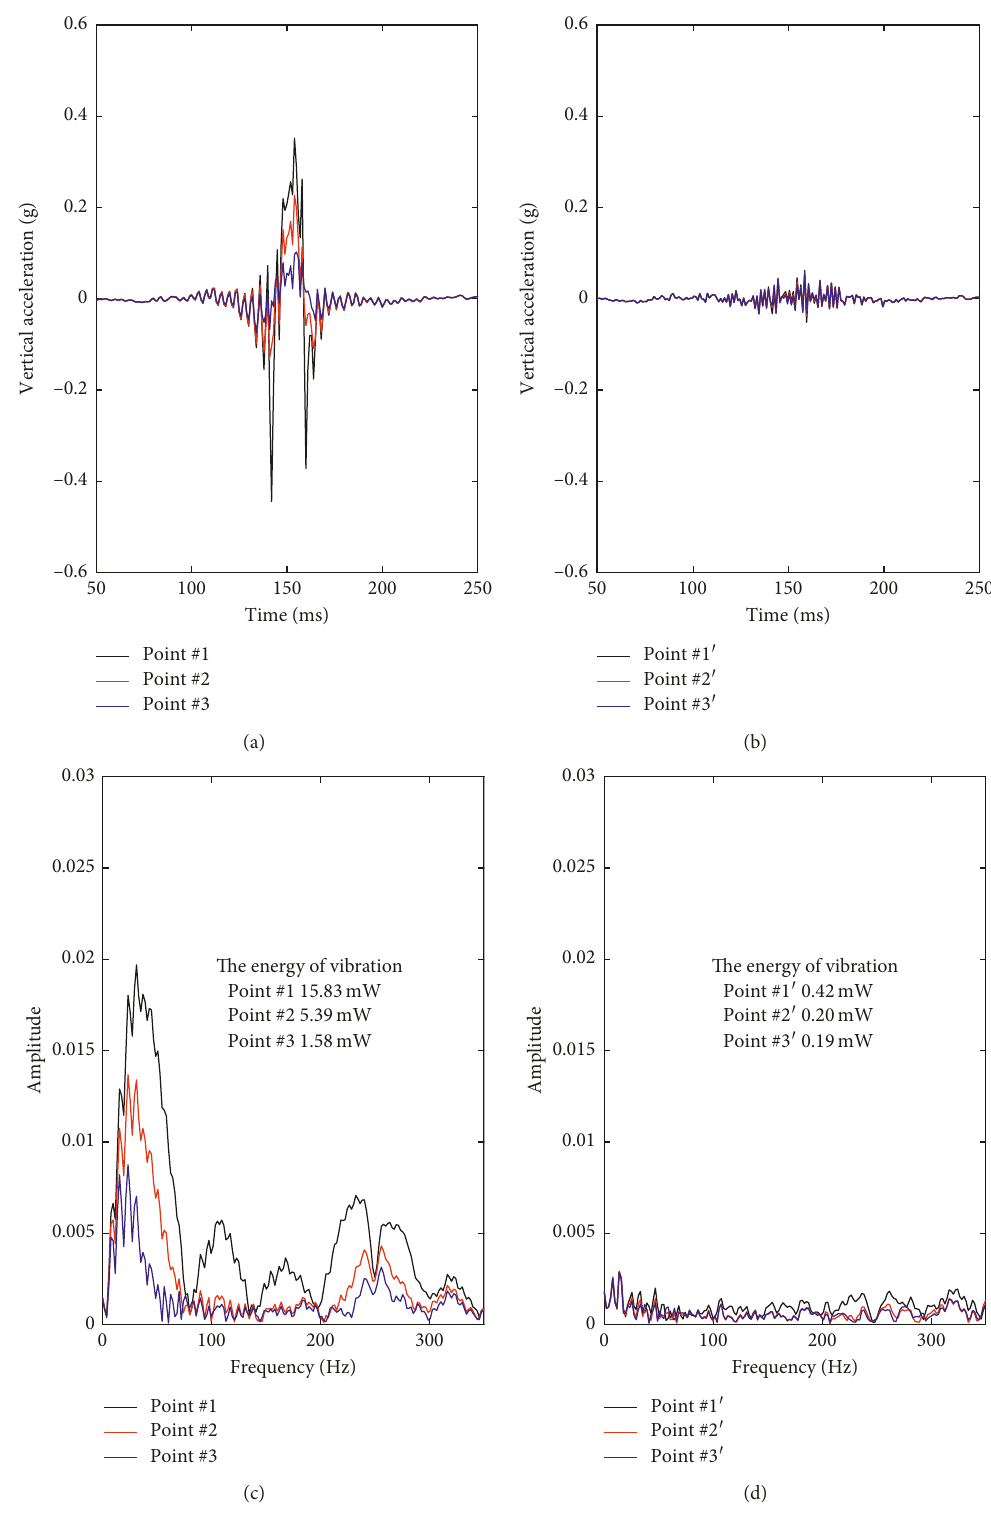
Figure 13: Comparison of vertical acceleration signals between asphalt and cement concrete pavements. (a) Time-domain vertical ac- celeration signals of asphalt concrete pavement. (b) Time-domain vertical acceleration signals of cement concrete pavement. (c) Frequency- domain vertical acceleration signals of asphalt concrete pavement. (d) Frequency-domain vertical acceleration signals of cement concrete